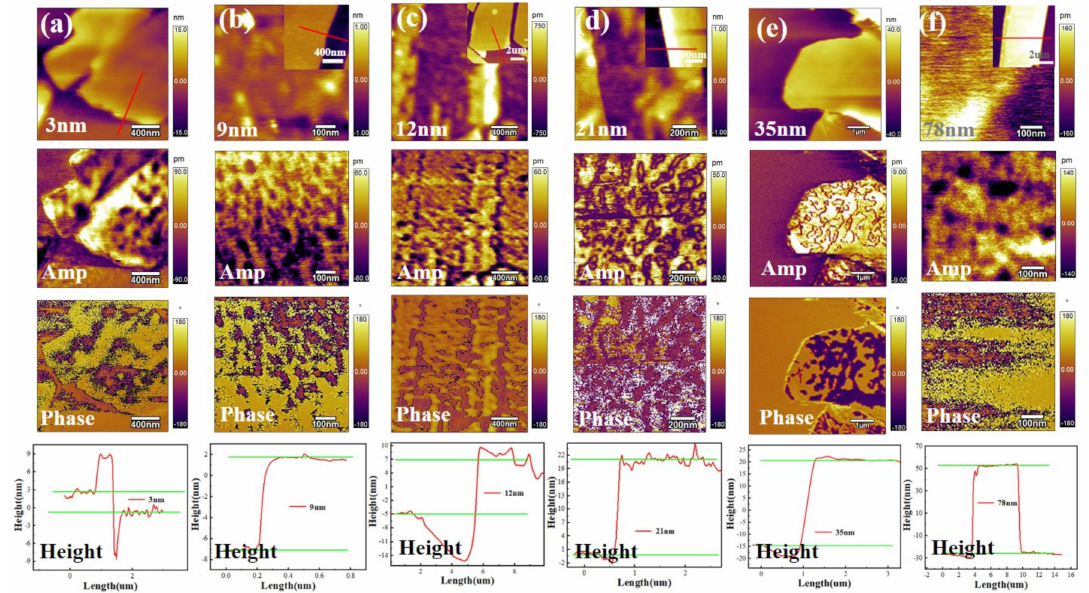
Figure 2. PFM images including height, amplitude, and phase image (upper three), and height curves (bottom row) of CIPS flakes with different thicknesses. ( a ) 3 nm, ( b ) 9 nm, ( c ) 12 nm, ( d ) 21 nm, ( e ) 35 nm, and ( f ) 78